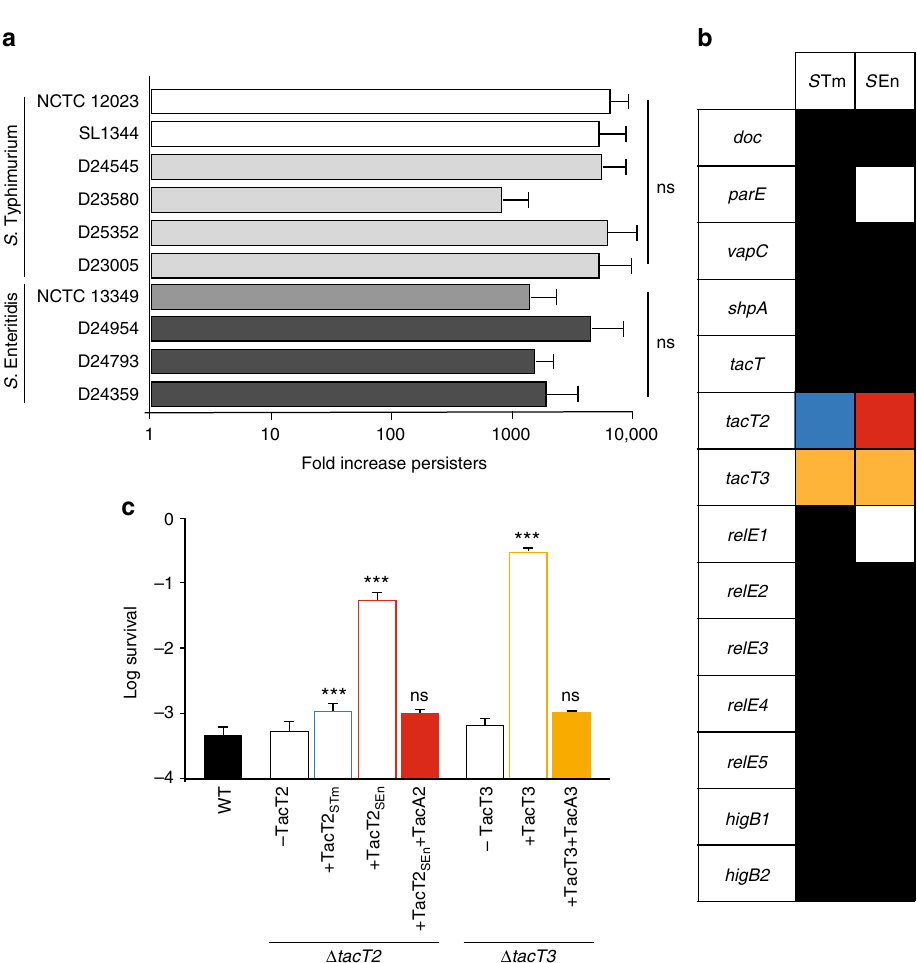
Fig. 1 Non-typhoidal Salmonella strains induce persister formation following internalization by human macrophages. a Fold increase in persisters caused by 30 min internalization in primary human macrophages relative to levels in inocula in clinical isolates of S . Typhimurium (white and light grey bars) and S . Enteritidis (dark grey bars), measured after exposure to gentamicin. Data represent the mean ± SEM ( n ≥ 5) and were analysed using one-way ANOVA. b Comparison of the repertoire of class II TA modules between S . Typhimurium and S . Enteritidis serovars. Boxes of same colour — fully conserved; white boxes — absence; different colour boxes — polymorphism. c Proportion of bacteria surviving 4 h exposure to bactericidal concentrations of cefotaxime in cultures of S . Typhimurium 12023 wild-type, Δ tacAT2 , Δ tacAT2 pBAD33:: tacT2 STm , Δ tacAT2 pBAD33:: tacT2 SEn , Δ tacAT2 pBAD33:: tacT2 SEn and pCA24N:: tacA2 , or Δ tacAT3 , Δ tacAT3 pBAD33:: tacT3 , Δ tacAT3 pBAD33:: tacT3 and pCA24N:: tacA3 . Arabinose and IPTG were added to all cultures in the fresh medium during the lag phase, then antibiotic treatment started 1 h later. Data represent the mean ± SEM ( n ≥ 3) and were analysed using a Student ’ s t test, compared to WT (ns, non-signi fi cant; *** p <